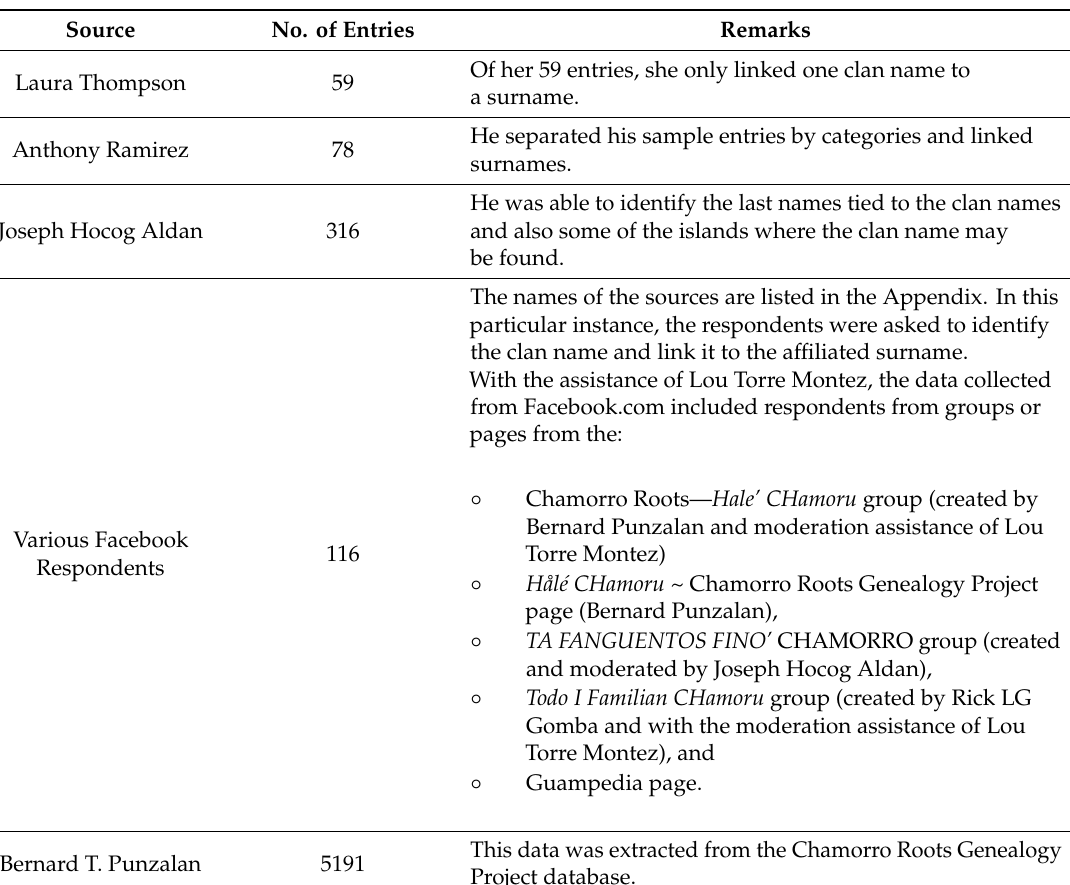
Table 2. Summary of Clan Name Source